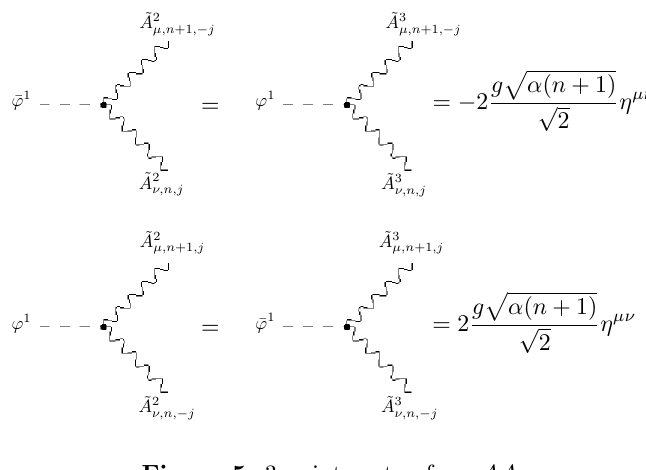
Figure 5 . 3-point vertex for ϕAA .